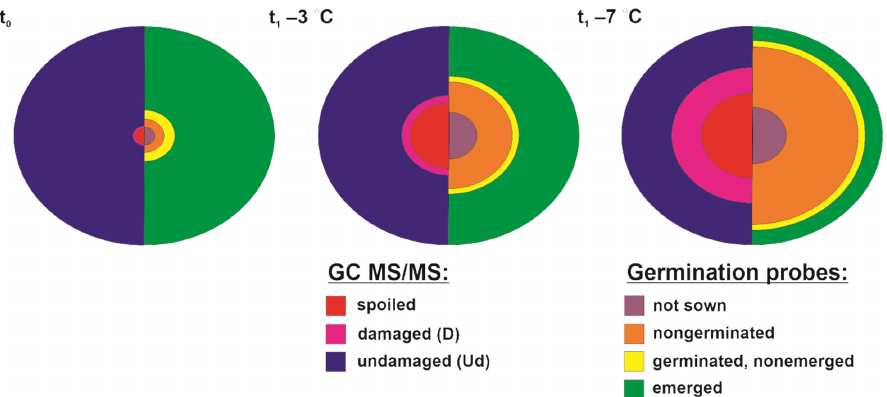
Figure 3. Graphical comparison of the average percentage distribution of classes utilized for germi- nation tests and metabolomics (GC MS/MS) involving nonstored seeds (t 0 ), seeds stored at − 3 °C (t 1 − 3 °C) and seeds stored at − 7 °C (t 1 − 7 °C). (t 1 − 3 ◦ C) and seeds stored at − 7 ◦ C (t 1 − 7 ◦